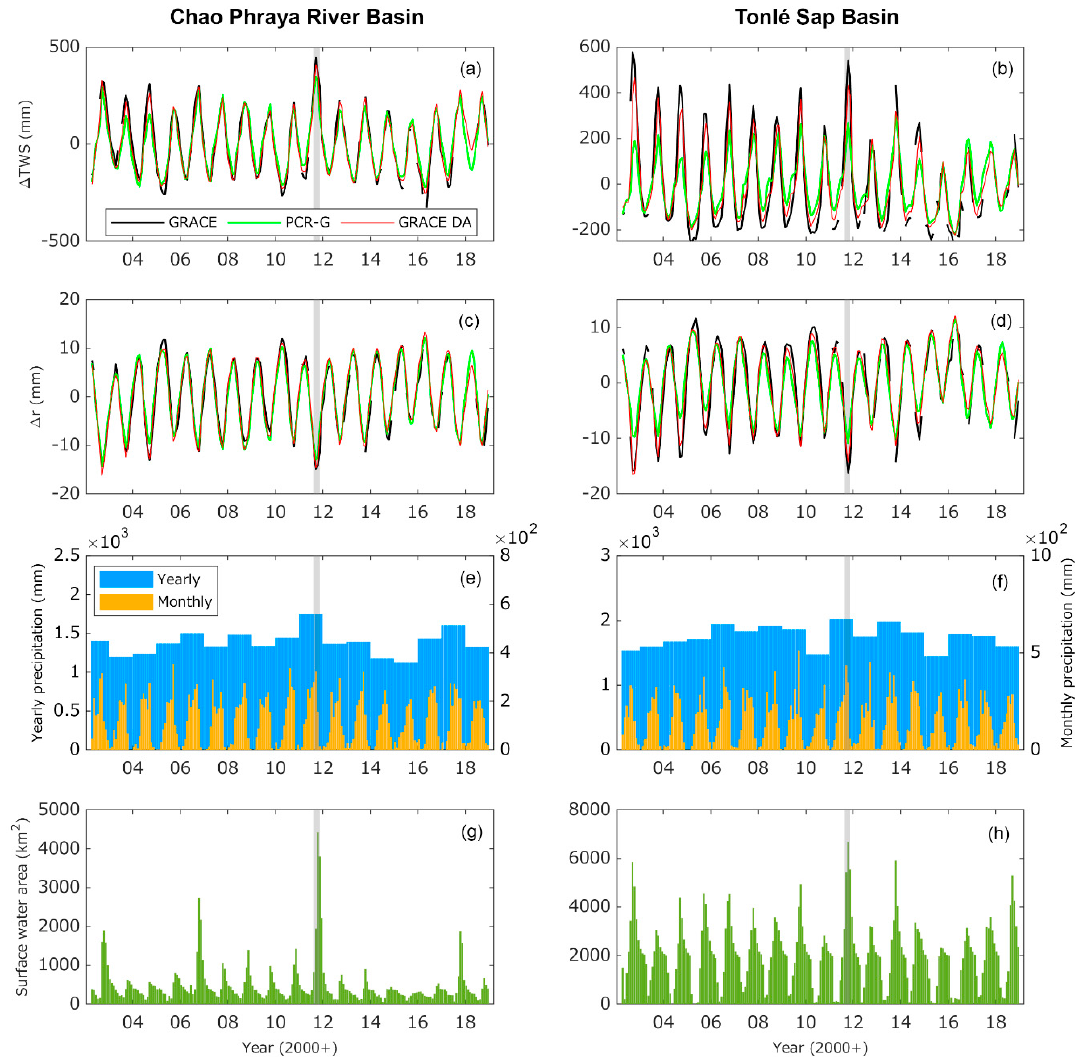
Figure 6. The basin-averaged ∆ TWS (first row; a , b ), ∆ r (second row; c , d ), Integrated Multi-satellite Retrievals for Global Precipitation Measurement Mission (IMERG)-derived precipitation (third row; e , f ), and MODIS-derived surface water extent (fourth row; g , h ) in the Chao Phraya River (first column) and Tonlé Sap (second column) Basins between April 2002 and December 2018. The gray background indicates the flood period of 2011. Table 2. Annual amplitude and statistical values (correlation coefficient ( ρ ) and root mean square difference (RMSD)) computed from the Gravity Recovery And Climate Experiment (GRACE), PCR-GLOBWB, and GRACE DA (data assimilation)-derived terrestrial water storage variation ( ∆ TWS) and vertical displacement variation ( ∆ r) time series in the Chao Phraya River and Tonl é Sap Basins. The ρ and RMSD values are computed with respect to the GRACE estimates. The percentage given in the GRACE DA results represents the improvement with respect to the PCR-GLOBWB estimate.